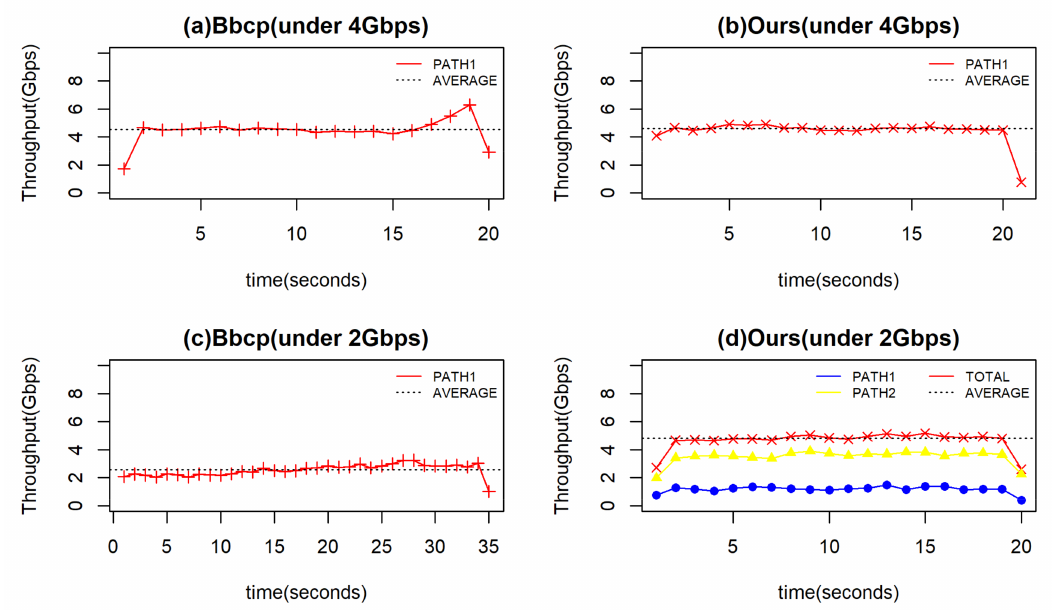
Figure 8. Results of comparison with end-to-end